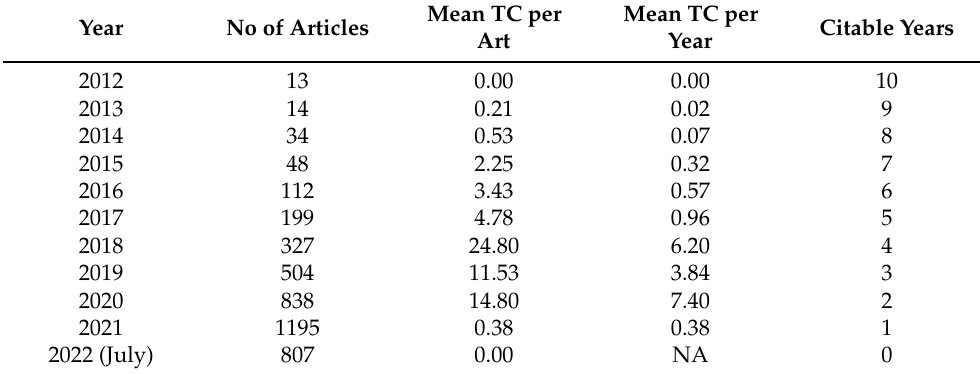
Table 3. Average Citation Per Year, TC: total